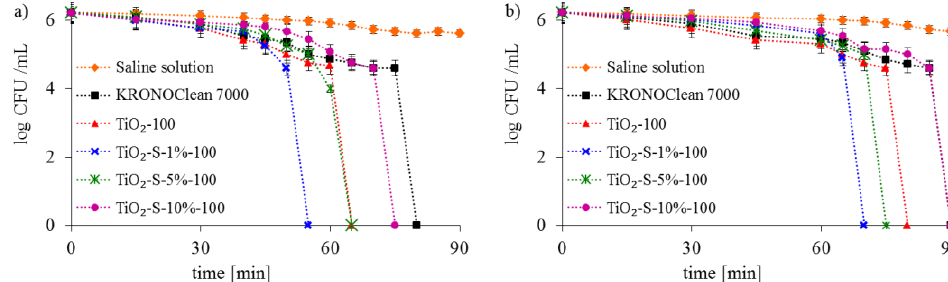
Figure 7. Inactivation of Gram-negative E. coli bacteria in the photocatalyst suspensions: ( a ) under UV-A; ( b ) under ASL irradiation.